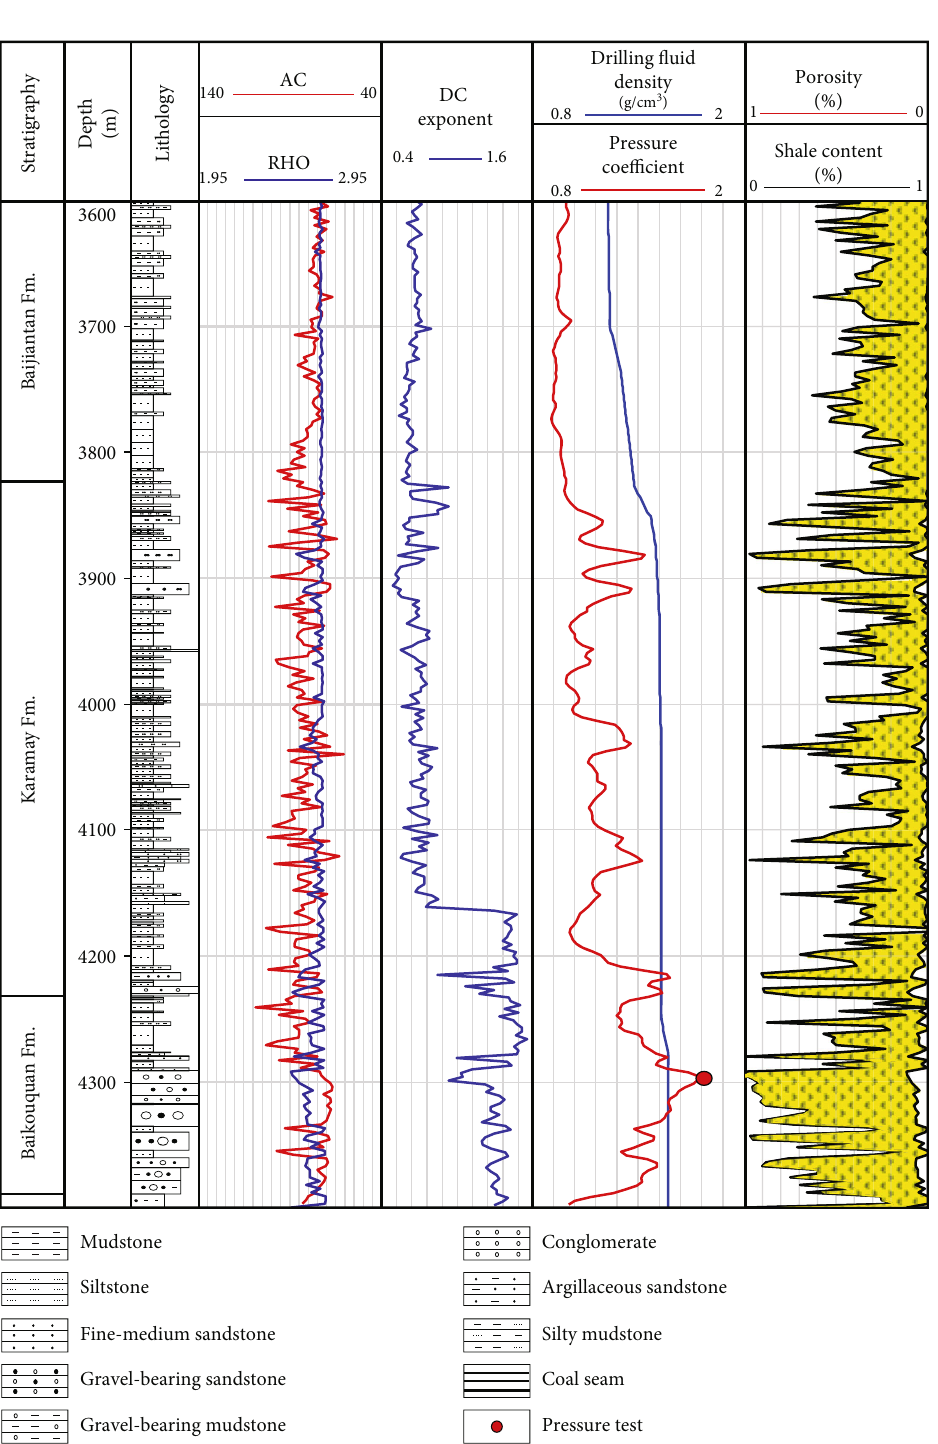
Figure 6: Triassic pressure analysis of Well D11 in the Mahu